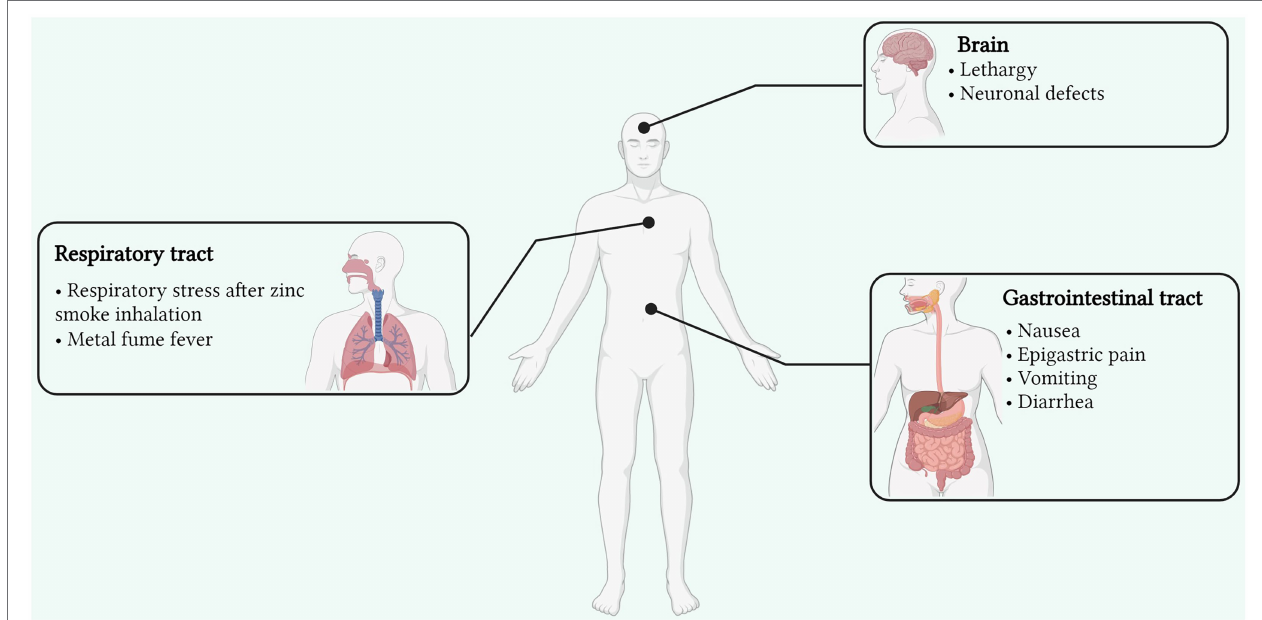
FIGURE 1 | Signs and symptoms of Zn toxicity affecting various organs and sites of the human body (Created with BioRender). Zn toxicity can occur via three primary routes; oral, dermal, and inadvertent inhalation. Though reversible, its toxicity can affect the respiratory and gastrointestinal tracts as well as the brain with various side effects. Inhalation of Zn fumes can induce metal fume fever arising from fume inhalation in industries, manifesting several symptoms in the case of acute exposure which include nausea, muscle fatigue, chest pain, cough, breathing distress, and